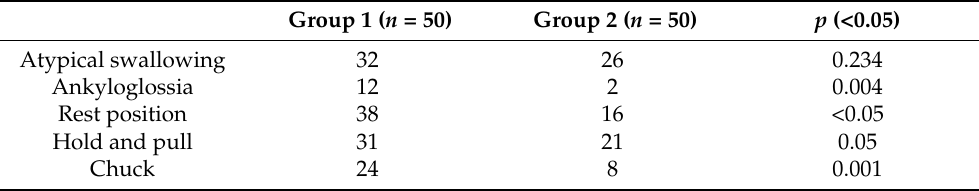
Table 2. Number of patients per group (G1 class III, n . 50, G2 class I, n . 50) with atypical swallowing, Ankyloglossia, and incapacity to have a correct rest position and to correctly perform the exercise. Statistical analysis using the chi-square